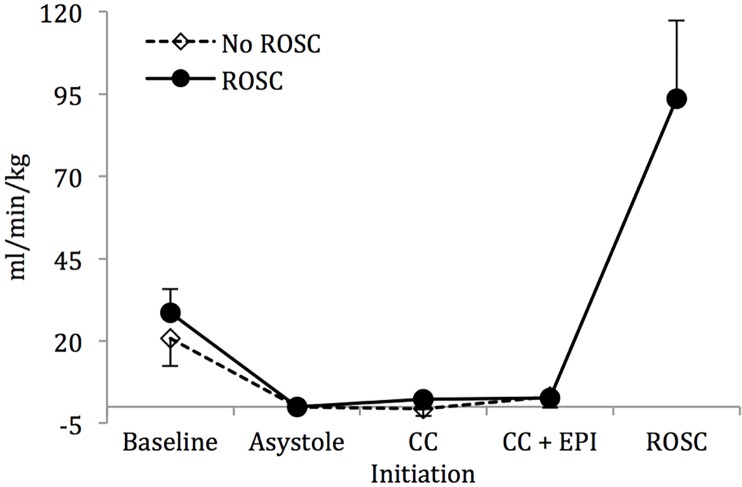
Mean left pulmonary artery flow.There is no appreciable increase in flow following initiation of chest compressions or after epinephrine administration. Data are mean ± SEM bars.